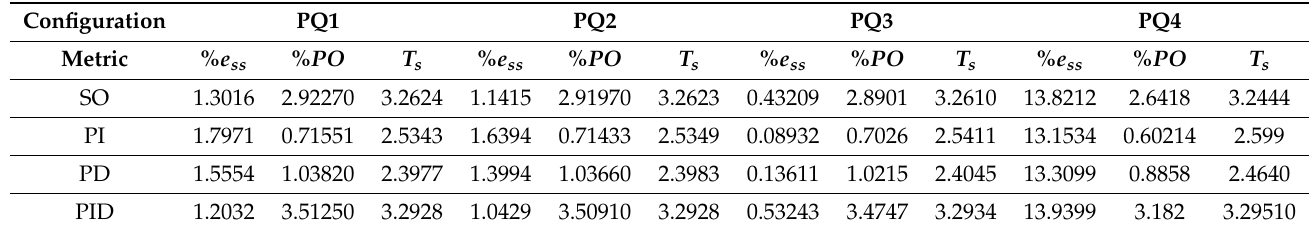
Table 3. Performance